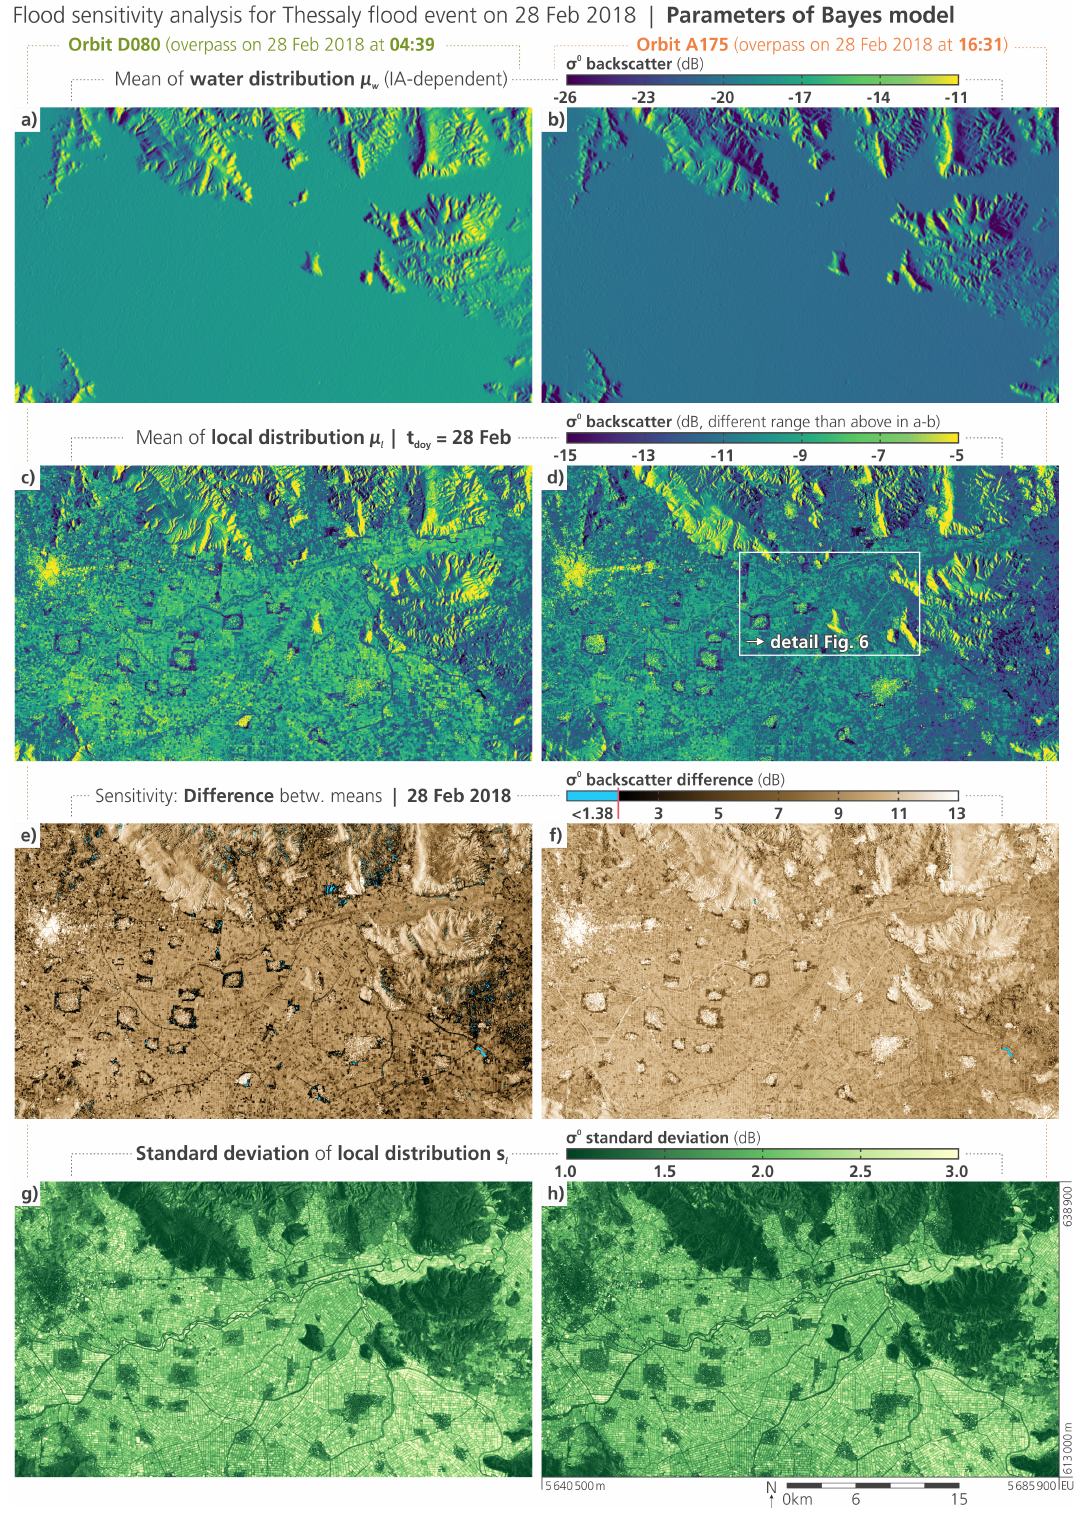
Figure 5. Over the complete study site in Thessaly, the Bayes flood algorithm spatial parameters for 28th February and Sentinel-1’s two overpasses in 2018. ( a , b ) The mean of water distribution µ l ( θ ) as a function of incidence angle θ . ( c , d ) The mean of local distribution µ l ( ρ , t ) from the harmonic model. ( e , f ) The differences between them indicating the flood model’s sensitivity for this configuration, and highlighted in blue the minimum difference evoking masking (cf. Section 2.5.2). ( g , h ) The standard deviation of the local distribution from Equation